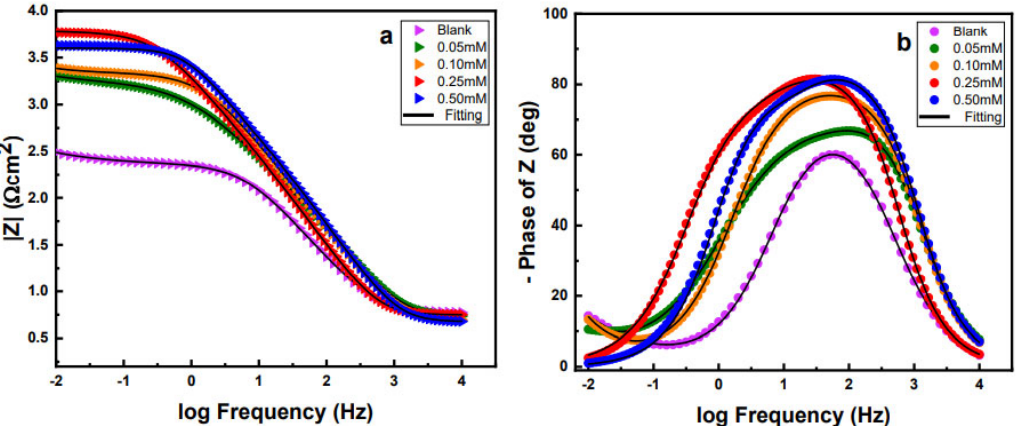
Figure 7. Bode magnitude ( a ) and Phase angle ( b ) plots of brass samples with and without different concentrations of corrosion inhibitors in 0.5 M H 2 SO 4 .